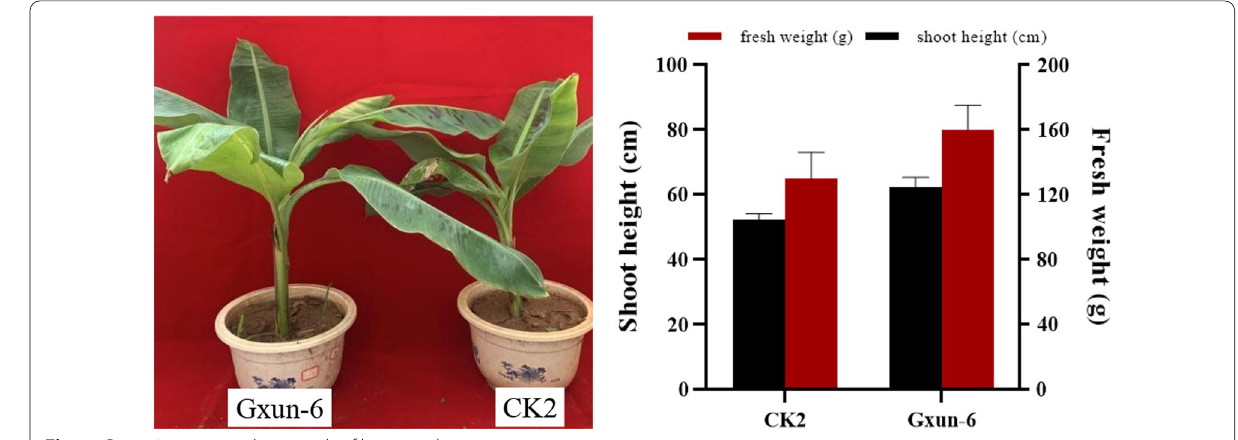
Fig. 7 Gxun-6 promotes the growth of banana plants